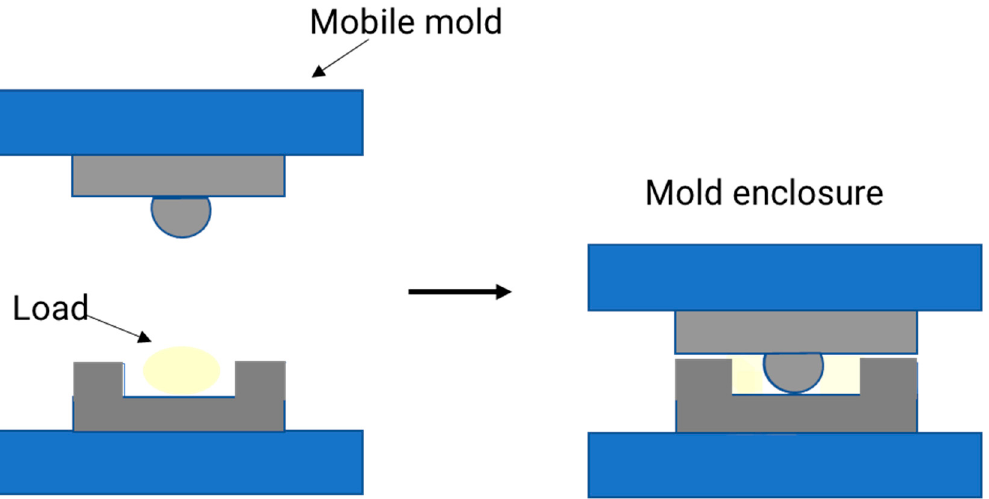
Figure 6. Scheme of the compression molding